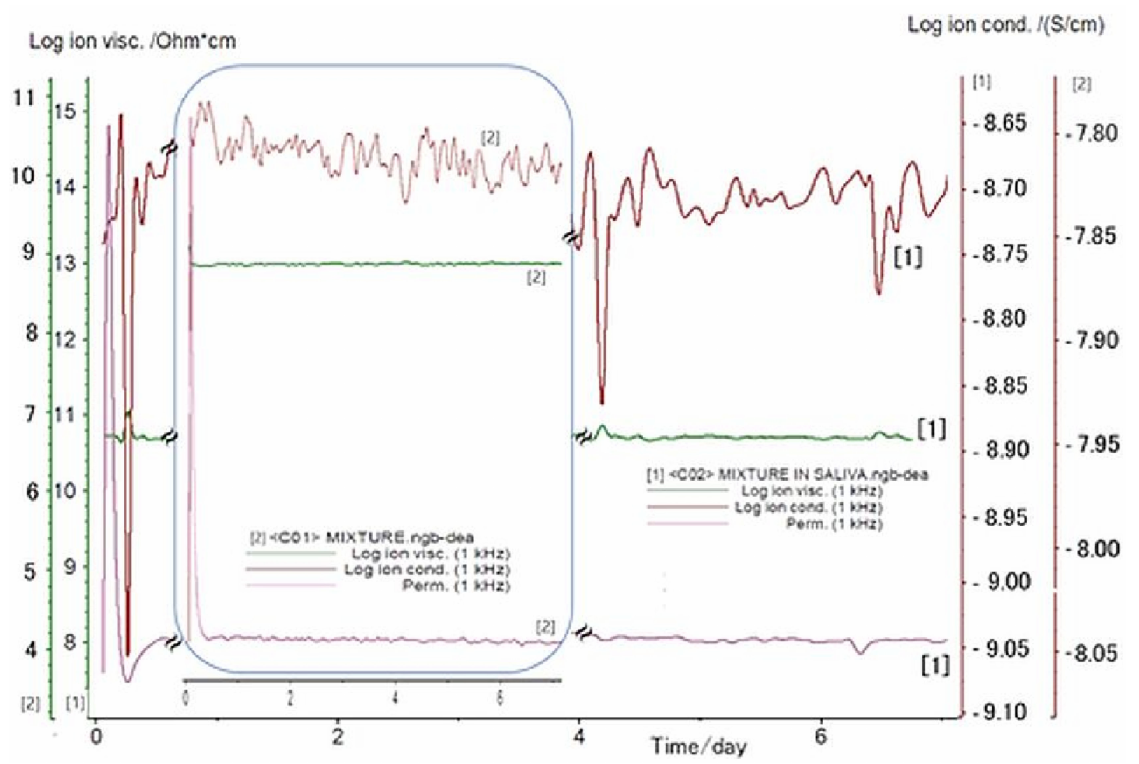
Figure 3. DEA analysis determined for the bioactive mixture immersed in saliva (1), and dry conditions (2).